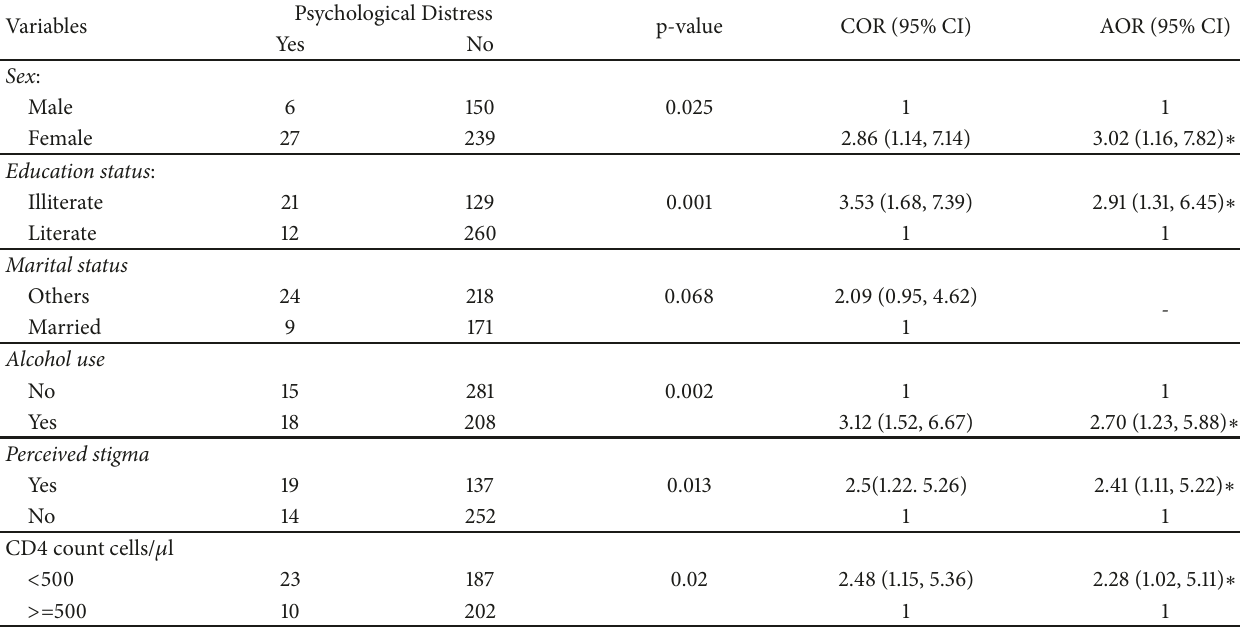
Table 3: Factors associated with the psychological distress of the participants among PLWHA at three selected hospitals ART clinics, North Shewa Zone, Amhara regional state, Ethiopia, 2017